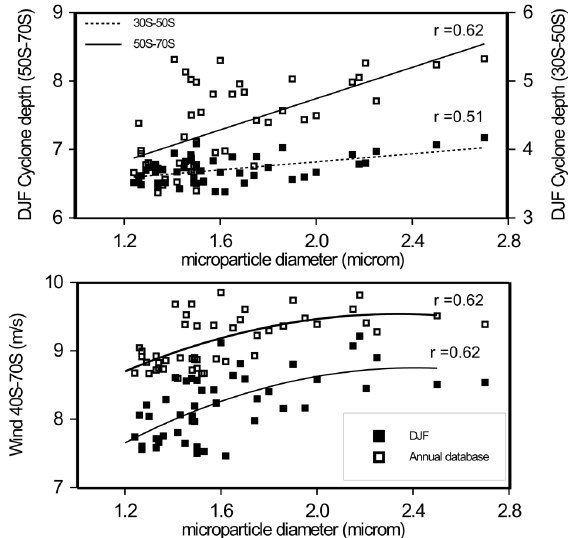
Fig. 5. (upper) Correlation between total insoluble microparticle diameter in Mount Johns ice core and DJF cyclone depth around Antarctica between 1960 and 2007; (bottom) the same as the previ- ous, but for wind intensity (40–70 ◦ S). A quadratic model was used to the best fit of the wind